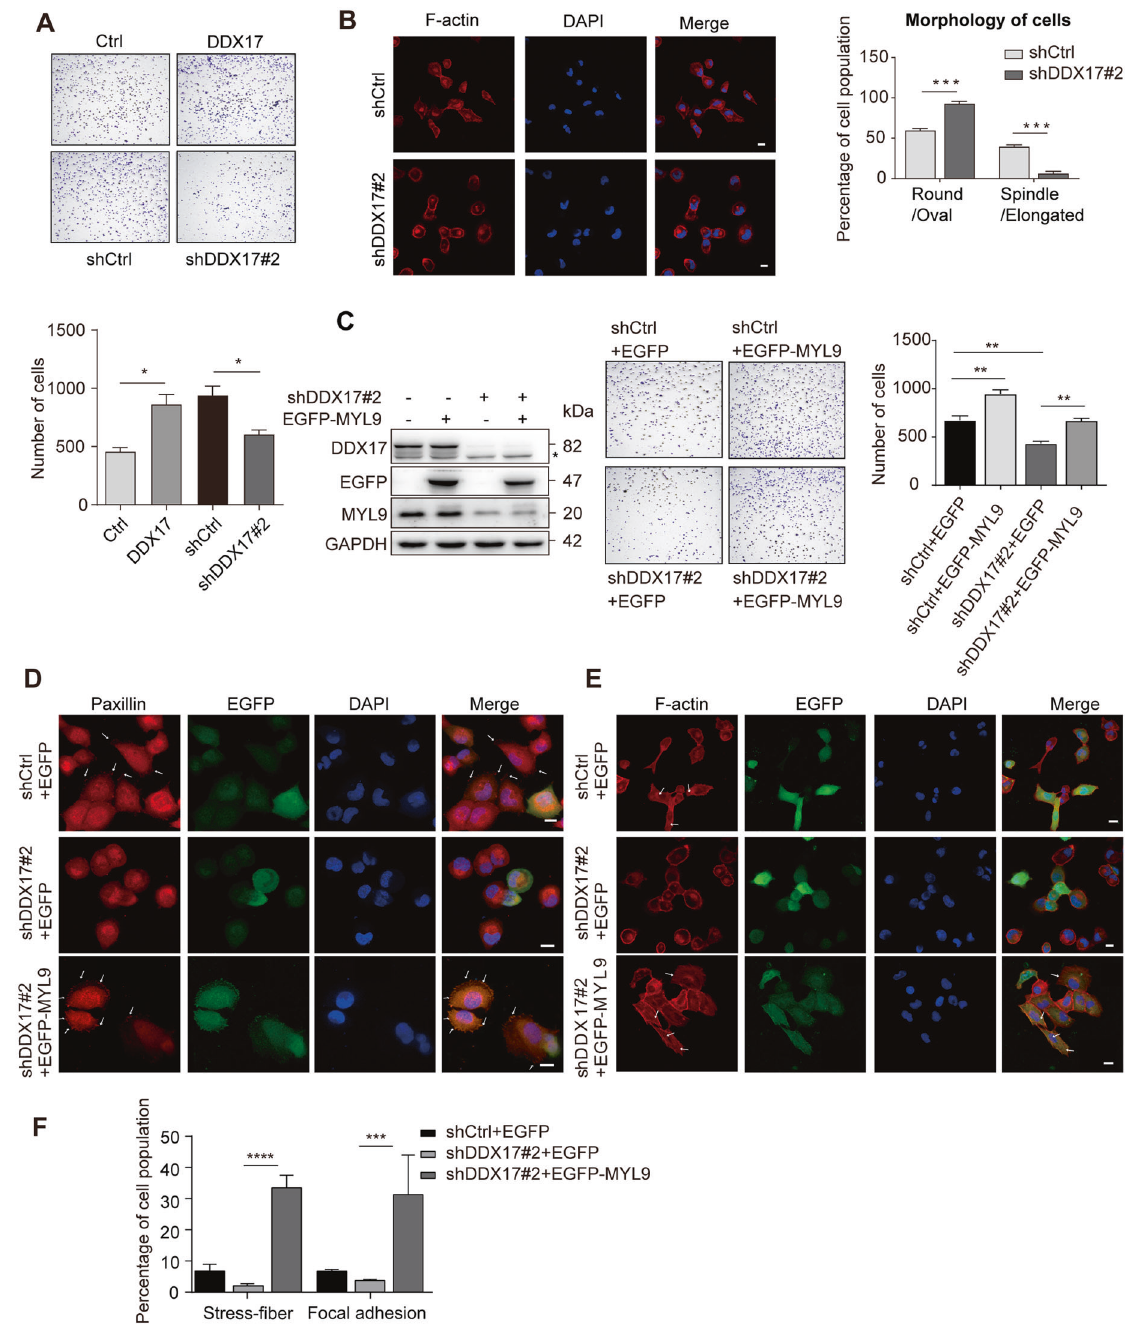
Fig. 4 DDX17 regulates cell adhesion and cytoskeleton reorganization of LUAD cells via its target MYL9. A Cell adhesion assays of DDX17- knockdown or overexpressing H1299 cells and corresponding control cells. Representative images (top) of the cells and cell counting results (bottom) were shown, and data are presented as mean ± s.e.m. from three independent experiments. *p < 0.05, determined by two-tailed Student ’ s t -tests. B F-actin cytoskeleton in shCtrl and shDDX17#2 H1299 cells was monitored by rhodamine-phalloidin staining. Nuclei were counterstained with DAPI (left panel). Scale bars: 10 μ m. Right pane: Cells with various morphology features were counted, (mean ± s.e.m. of counted cells, n ≥ 30 cells per cohort, determined by two-tailed Student ’ s t -tests). C H1299-shDDX17#2 cells or control cells were transiently transfected with EGFP-MYL9 or control plasmids, and analyzed by western blotting with appropriate antibodies (left); representative photos of cell adhesion assays with the indicated cells (middle) and the corresponding quanti fi cation analyses, and data are presented as mean ± s.e.m. from three independent experiments. **p < 0.01, determined by two-way ANOVA (right). D Representative images of IF staining of Paxillin of the indicated cells. E F-actin cytoskeleton staining using rhodamine-phalloidin. Scale bars: 10 μ m. F Quanti fi cation analysis of stress fi ber and FAs formation. Data are presented as mean ± s.e.m. from three independent experiments. ***p < 0.001, determined by two-way